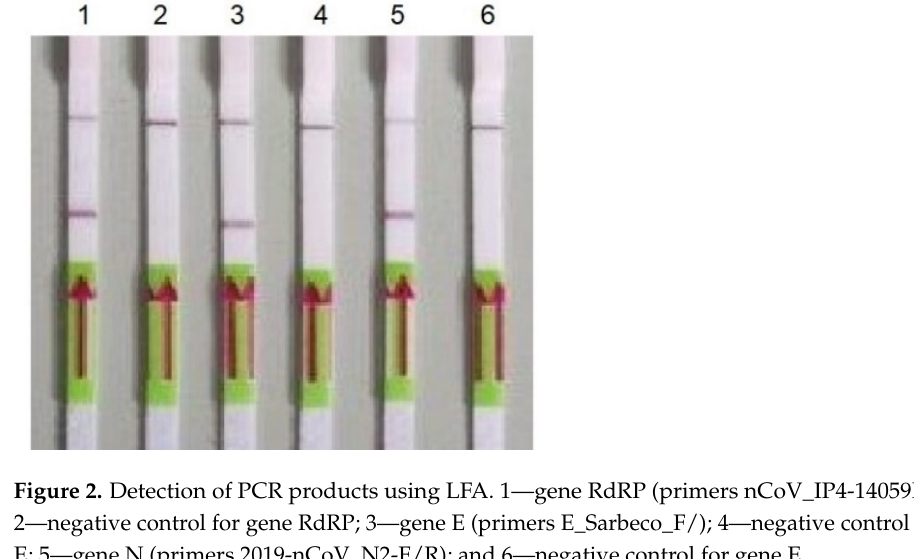
Figure 1. Agarose gel electrophoresis of PCR products: M—molecular DNA marker 100 bp; 1—PCR for gene RdRP (primers nCoV_IP4 ‐ 14059Fw/Rv); 2—negative control for gene RdRP; 3—PCR for gene E (primers E_Sarbeco_F/R); 4—negative control for gene E; 5—PCR for gene N (primers 2019 ‐ nCoV_N2 ‐ F/R); and 6—negative control for gene N.